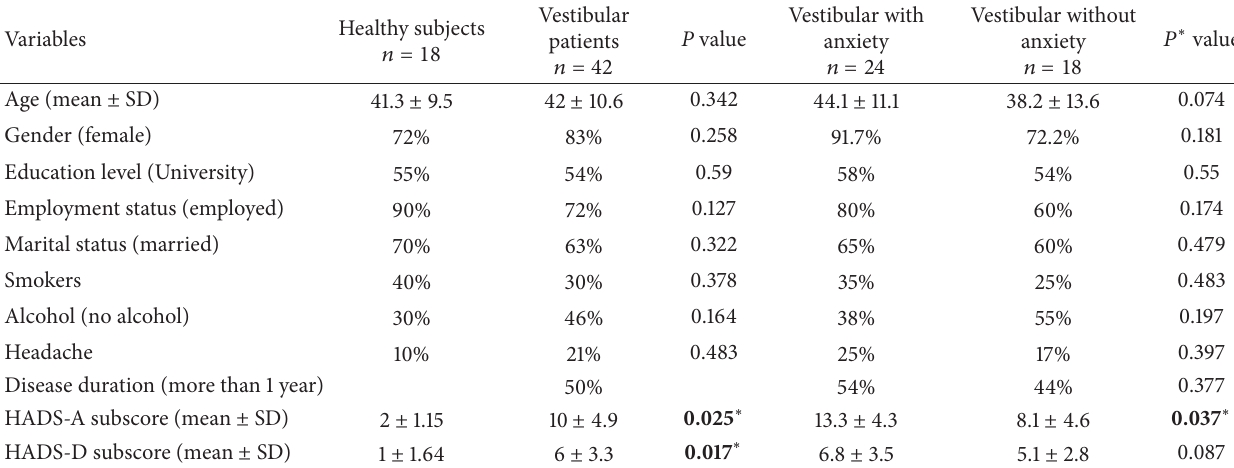
Table 1: General characteristics of the subjects and comparisons between